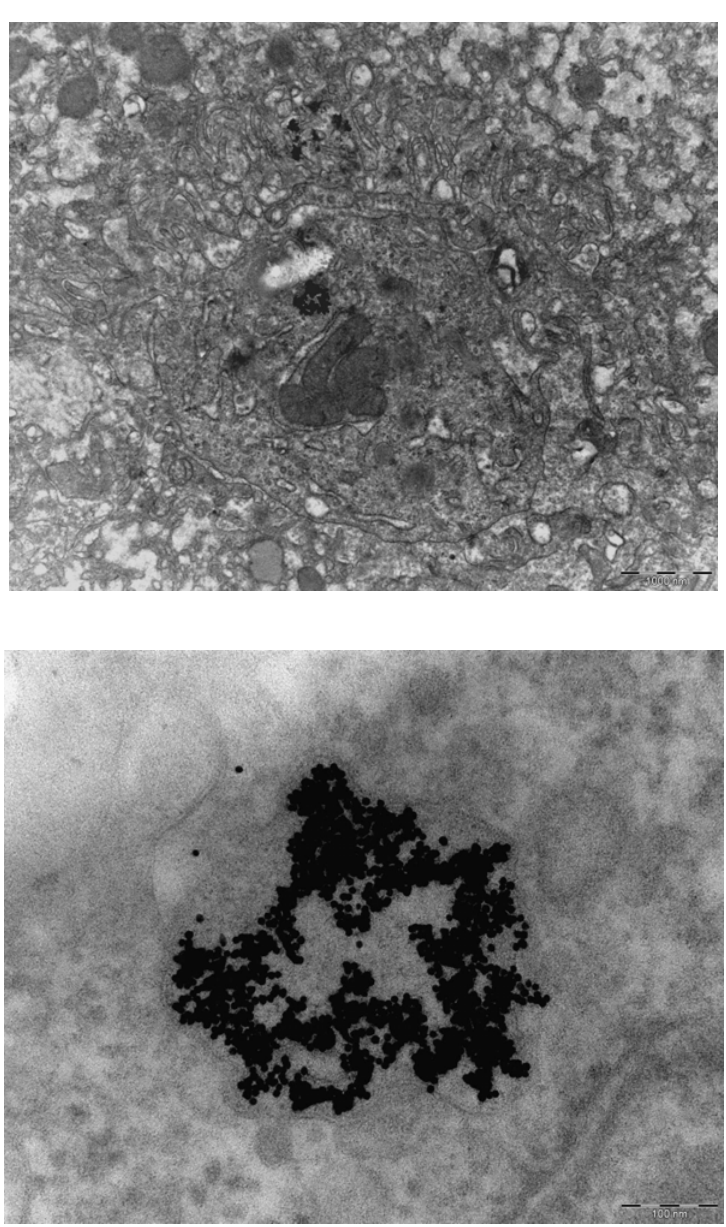
Figure 6. Presence of gold nanoparticles in Kupffer cells of the liver. Top. Presence of aggregates of 10 nm gold nanopartiocles in phago–lysosomes in Kupffer cells of the liver. The marker indicates 1000 nm. Bottom. Detail of nanoparticle aggregate in phago-lysosome. The marker indicates 100